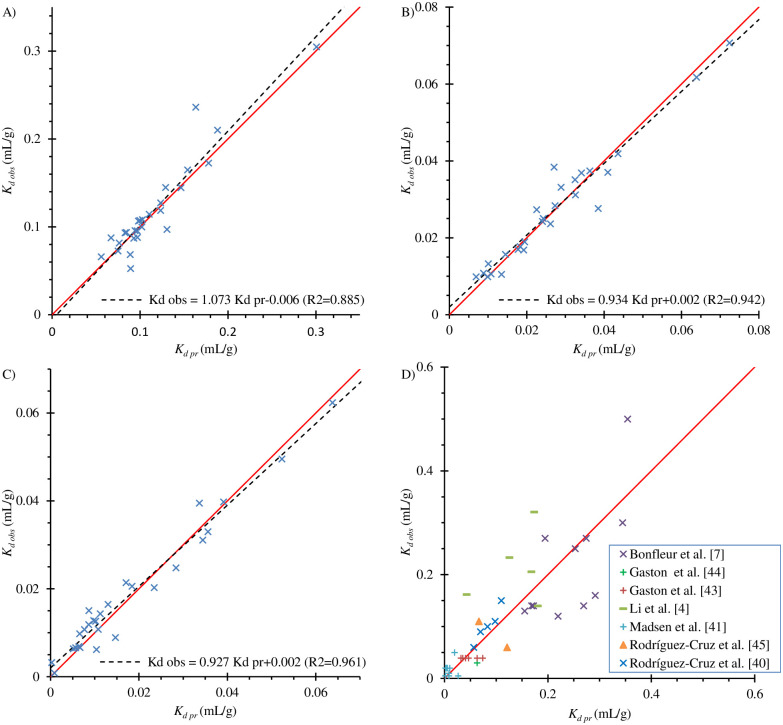
Observed versus predicted using Eq (5)
Kd values for the examined topsoil (A), upper (B), and lower subsoil horizons (C) as well as Kd values observed by the other authors versus the Kd values predicted using Eq (5) (D).